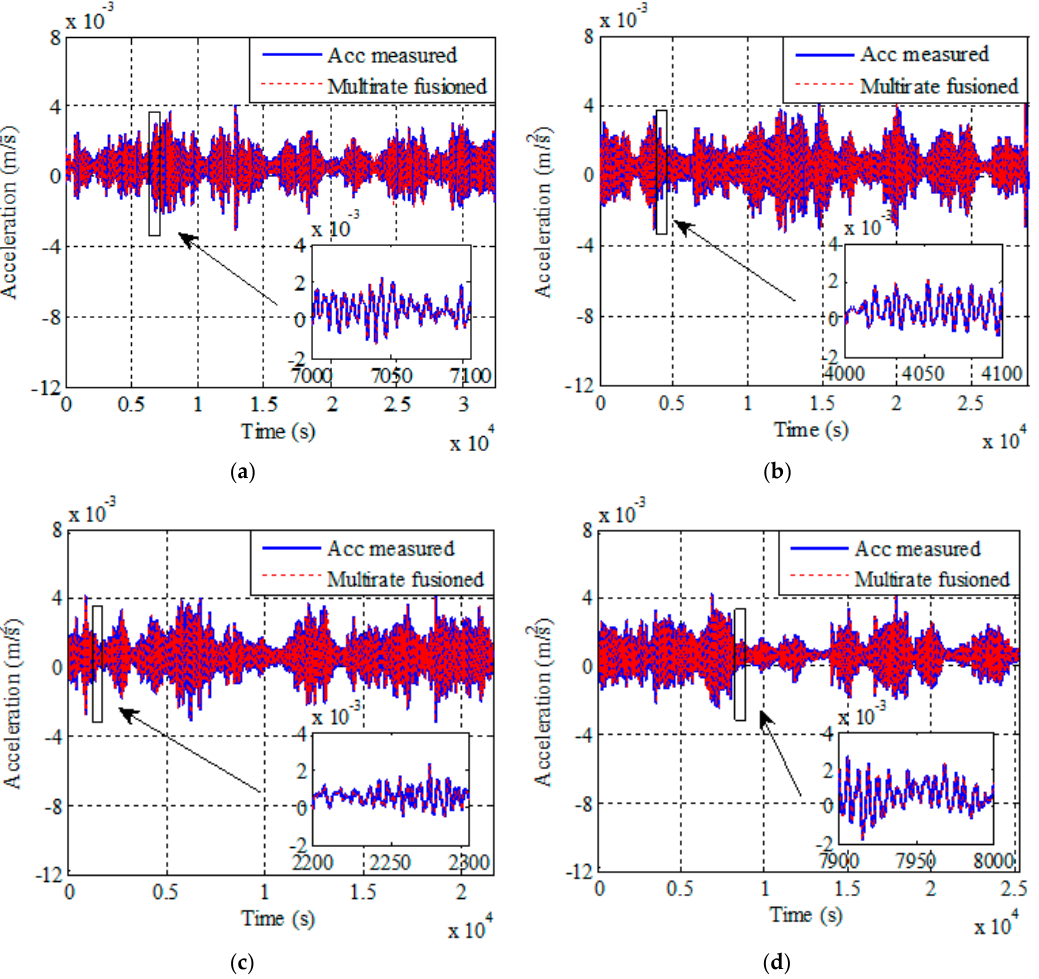
Figure 7. Acceleration measured data and improved multi-rate fusion acceleration results from Cases 1–4. ( a ) Case 1. ( b ) Case 2. ( c ) Case 3. ( d ) Case 4.